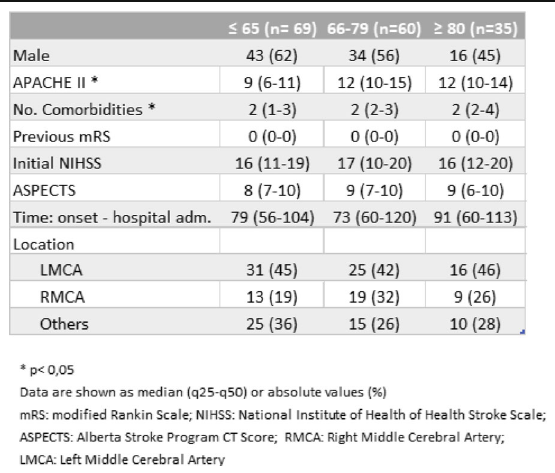
Table 1 (abstract 0360). See text for description